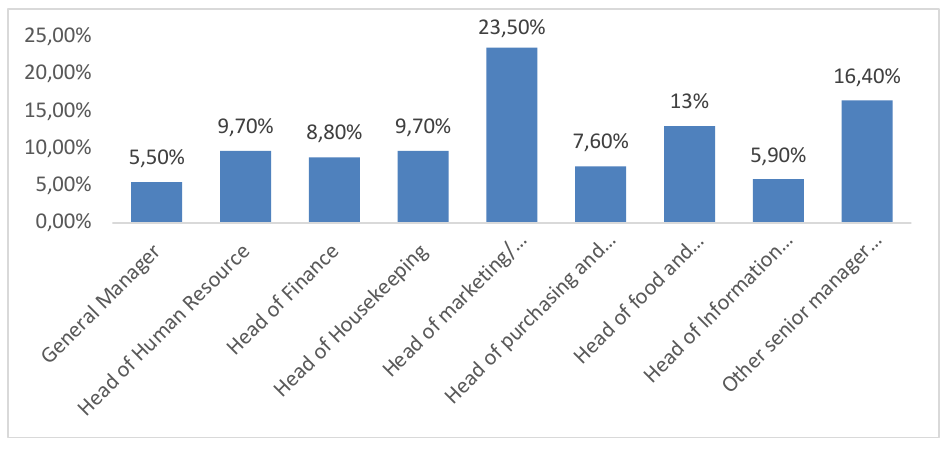
Figure 1 : Respondents’